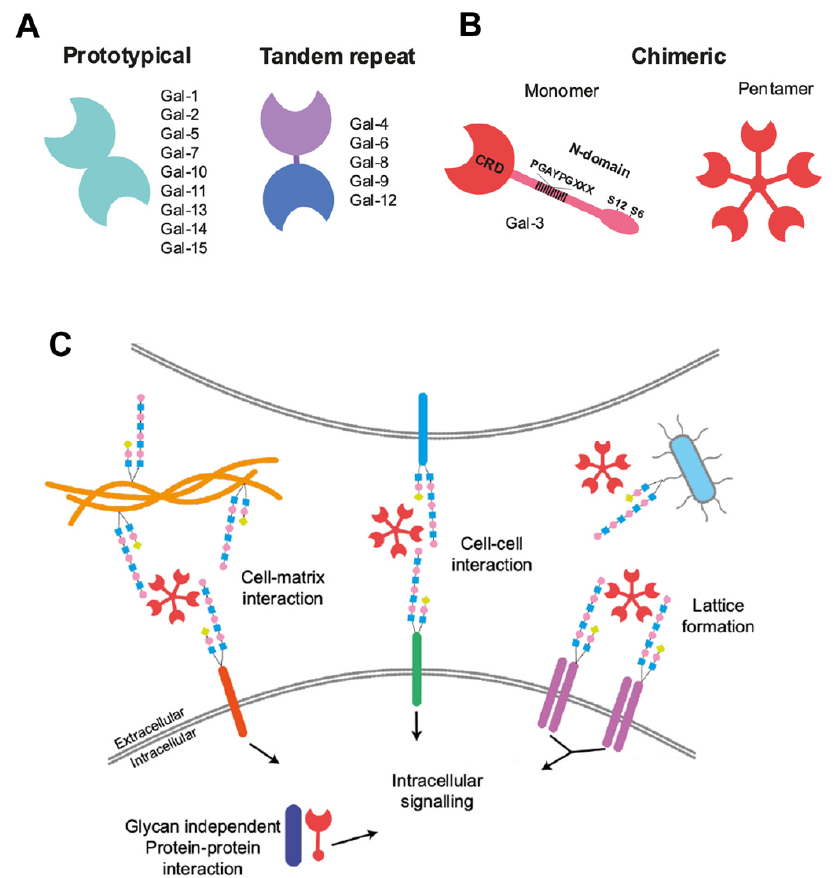
Figure 1. Schematics of Galectin-3 structure and function ( A ) Galectin subtypes and homology. Adapted from [4], ( B ) N -glycan binding partners of Gal-3. Adapted from [5], ( C ) Galectin-3 interac- tions. Adapted from [4], with permission.